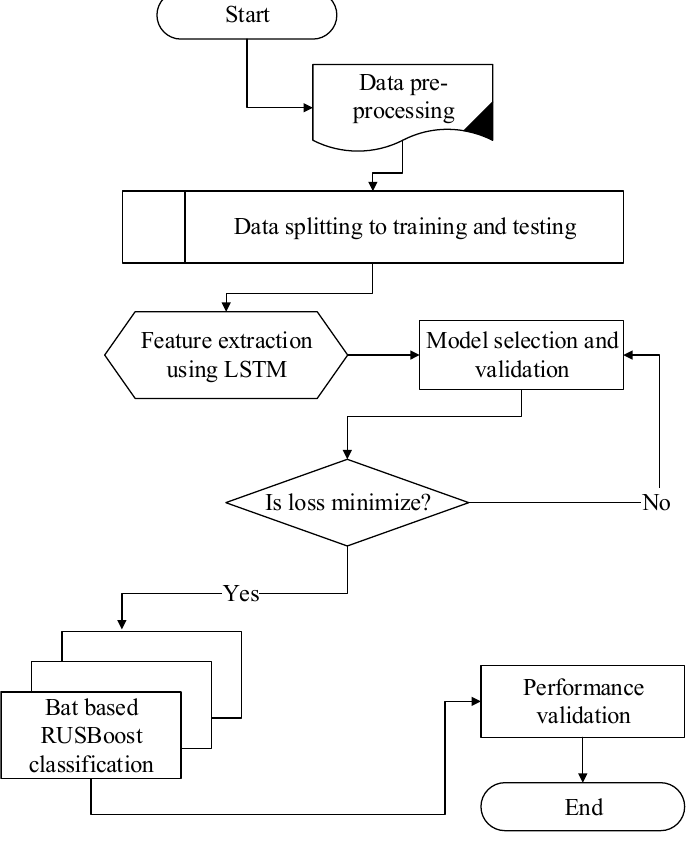
Figure 3. Methodology for